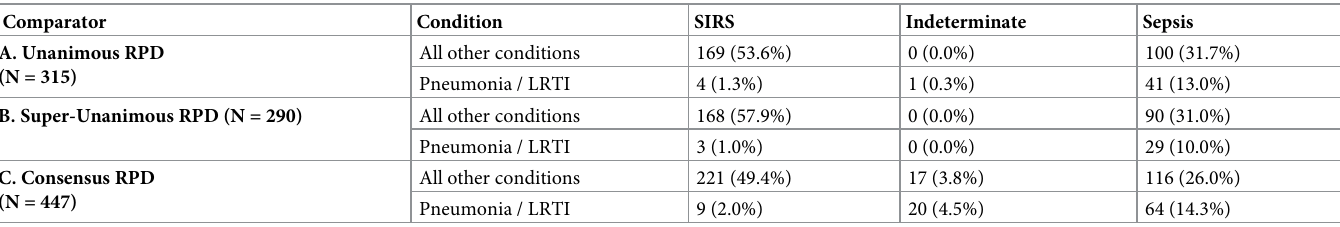
Table 3. Classification of patients in a trial on a new sepsis diagnostic test.